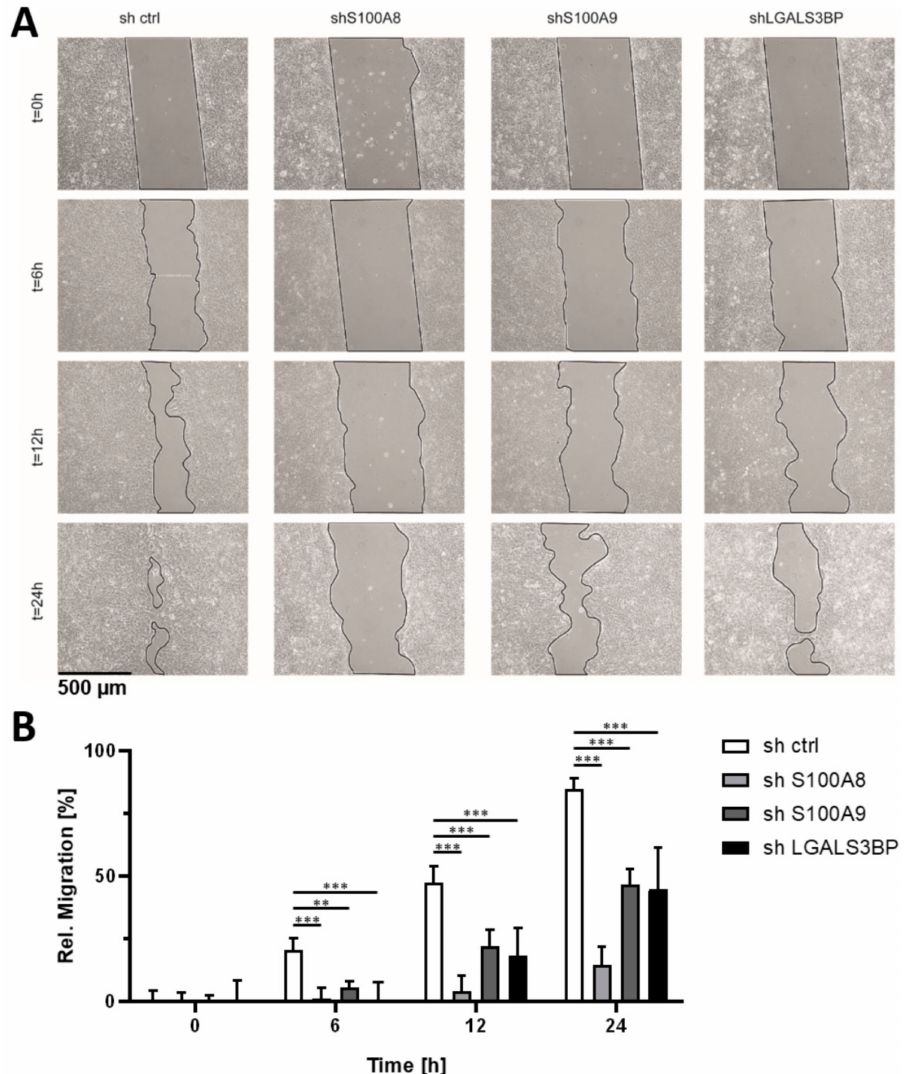
Figure 5. Inhibition of S100A8, S100A9, and LGALS3BP expression impairs migration of pancreatic cancer cell line L3.6sl. ( A ) Representative images of the specific knockdown cells (shS100A8, shS100A9, and shLGALS3BP) compared to non-target control shRNA cells (sh ctrl) shown are after 0.0, 6.0, 12.0, and 24.0 h. Black lines enclose areas free of migratory cancer cells. Quantification of migration ability over time ( B ): 0.0 h control shRNA area was set to 0%; all other values were normalized accordingly. Measurements were done with the ProgRes Software. Error bars represent standard deviations of six measurements. Statistical significances were assessed by a two-way ANOVA followed by a Dunnett’s post-hoc test (* for p ≤ 0.05, ** for p ≤ 0.01. and *** for p ≤ 0.001, n =